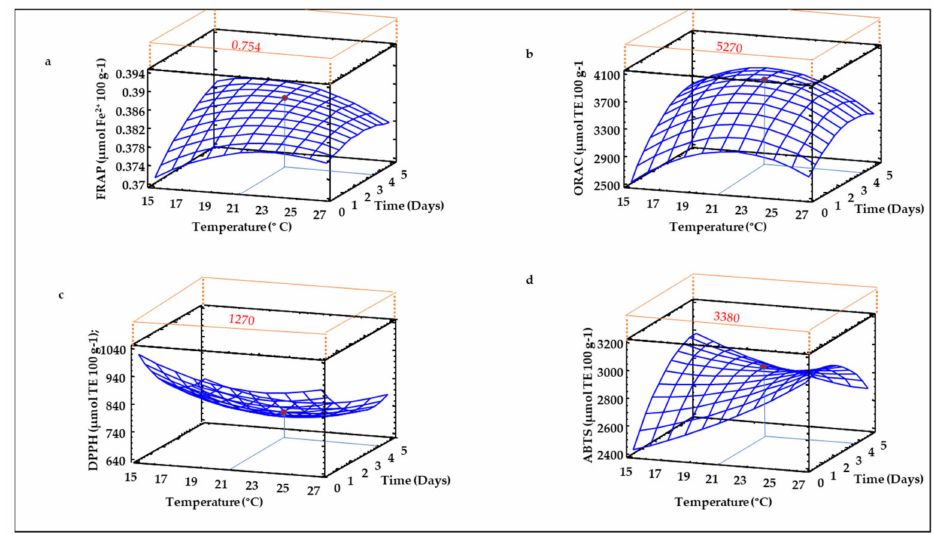
Figure 9. Three-dimensional response surface plots for antioxidant activity measured by FRAP (mmol Fe 2+ 100 g − 1 ) ( a ), ORAC, DPPH • , ABTS • + ( µ mol Eq. Trolox 100 g − 1 ) ( b – d ) as a function of the interaction between germination temperature and time. The red line corresponds with the control (ungerminated seed) and the red point with the value for optimum conditions (21 ◦ C and 3.5